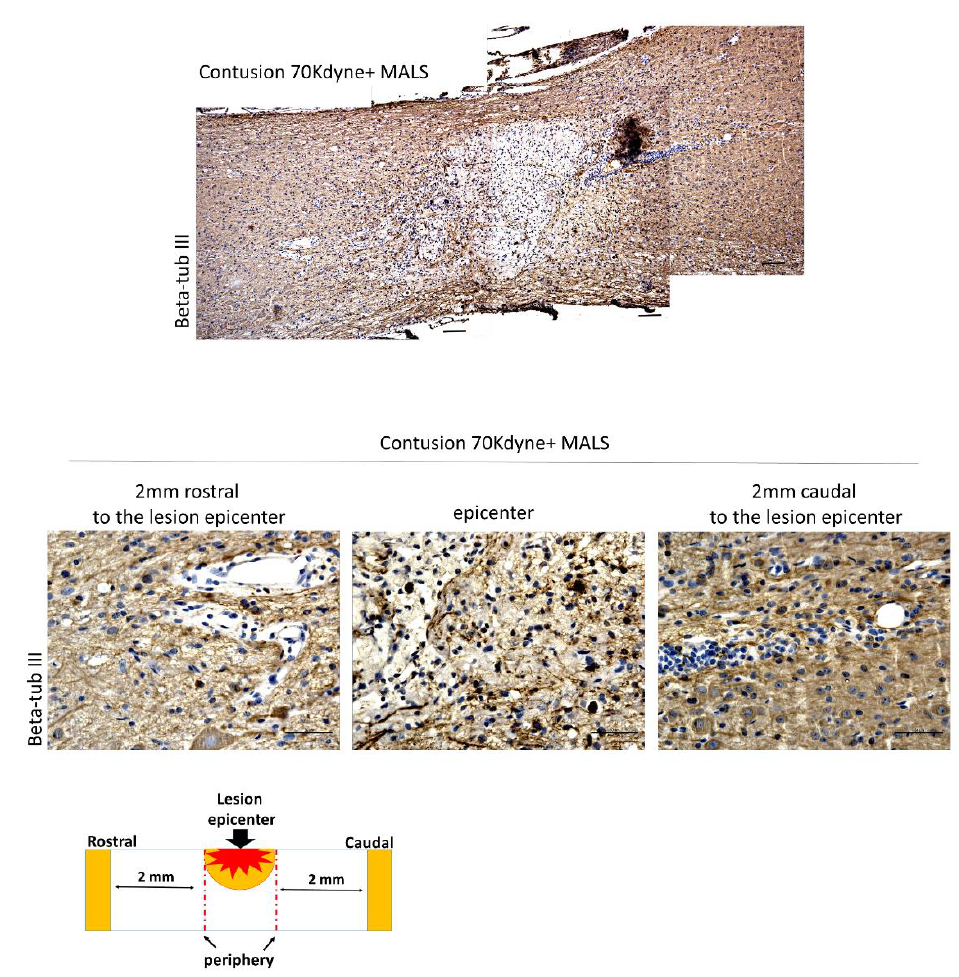
Figure 8. Spinal cords engrafted with MALS show neuronal presence at lesion site. The epicenter of the lesion and the surrounding areas (2 mm rostral and 2 mm caudal) were evaluated for the presence of neuronal markers expression beta-tub III. It is possible to appreciate beta-tub III positive cells in the analyzed regions. Scale bars: 100 and 50 µm. (n = 4 mice; 2 sections/mouse; 3 field/section).